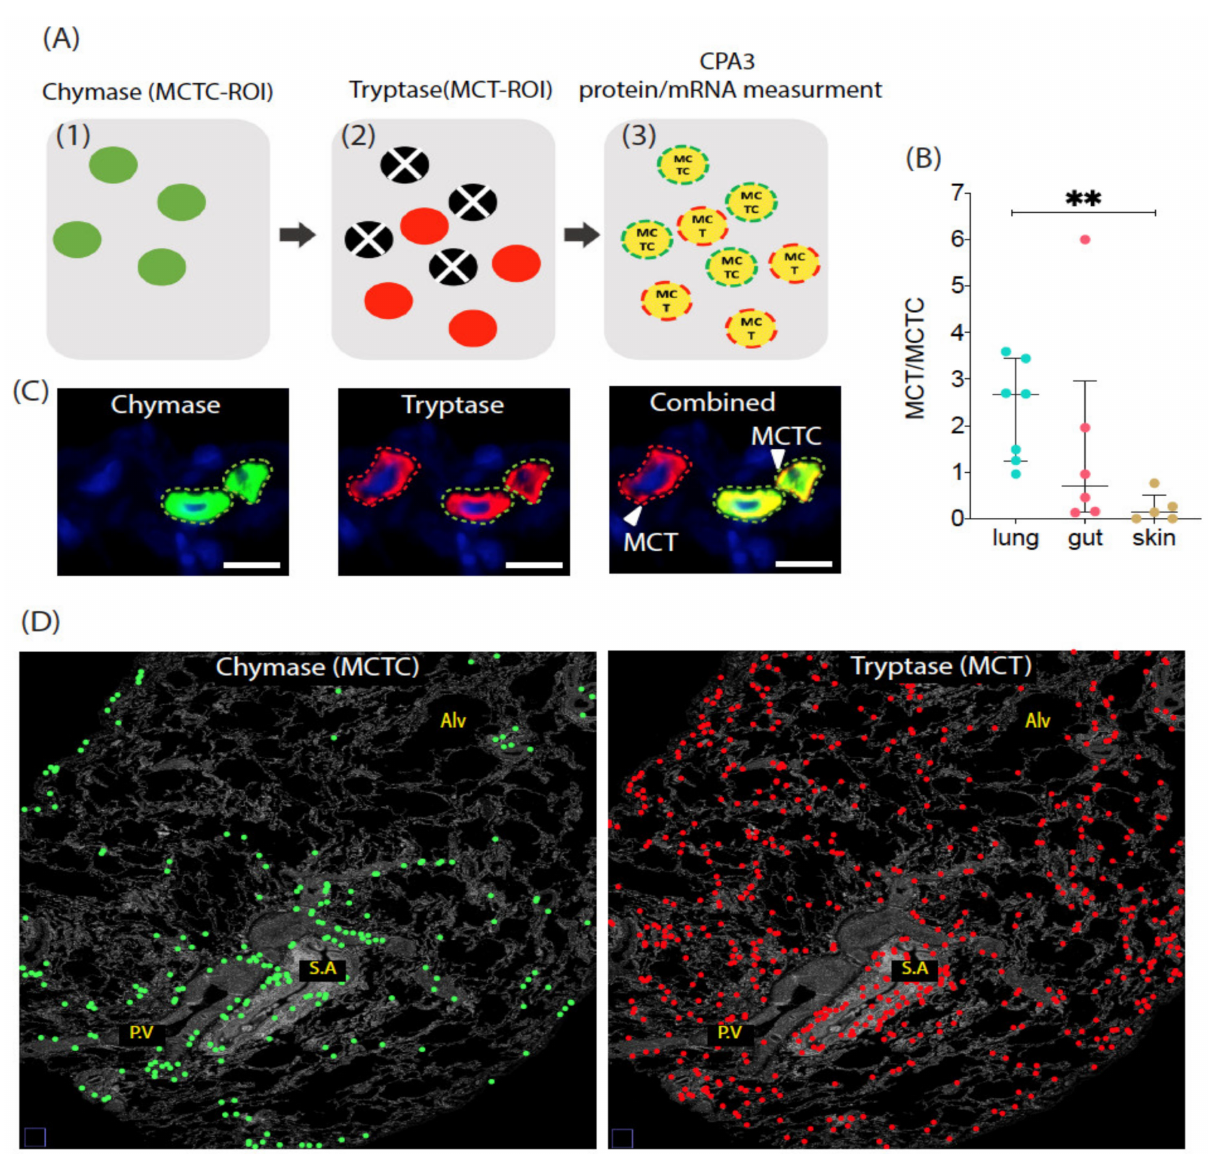
Figure 1. ( A ) A schematic overview of the principle used to quantify the human lung-, gut- and skin-tissue-residing MCT (tryptase + , chymase - ) and MCTC (tryptase + , chymase + ) mast cell subpopulations. The mRNA and protein were measured at the single-cell level by performing fluorescence in situ hybridization (FISH) and subsequent immunofluorescence staining. Following the staining procedure, slides were digitalized into high-resolution 16-bit images. Next, combined chymase and tryptase Regions of Interest (ROIs) with tryptase and/or chymase were segmented by a locked-intensity threshold. Finally, the combined MC ROIs were categorized as MCT (tryptase only) and MCTC (tryptase + chymase) objects, which were used as guiding points to quantify the mRNA and protein of interest per cell object basis using a semi-automated ImageJ platform. ( B ) The proportion of MCT and MCTC in lung, gut and skin. Statistical difference levels were calculated by Statistics–Dunn’s multiple comparisons test ns- p > 0.05, ** p ≤ 0.01, ( C ) Immunofluorescence micrographs of close-up single and combined tryptase and chymase cell profiles. ( D ) Micrographs exemplifying part of a lung surgical resection section area where the spatial distribution of 229 segmented MCTC and 637 MCT masks (ROIs) is illustrated by color-coded circles. Alv, alveolar parenchyma; PV, pulmonary vessels; SA, small airways (i.e.,